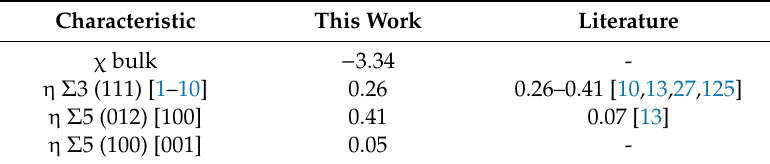
Table 5. Partial cohesive energy and strengthening energies, given in eV /